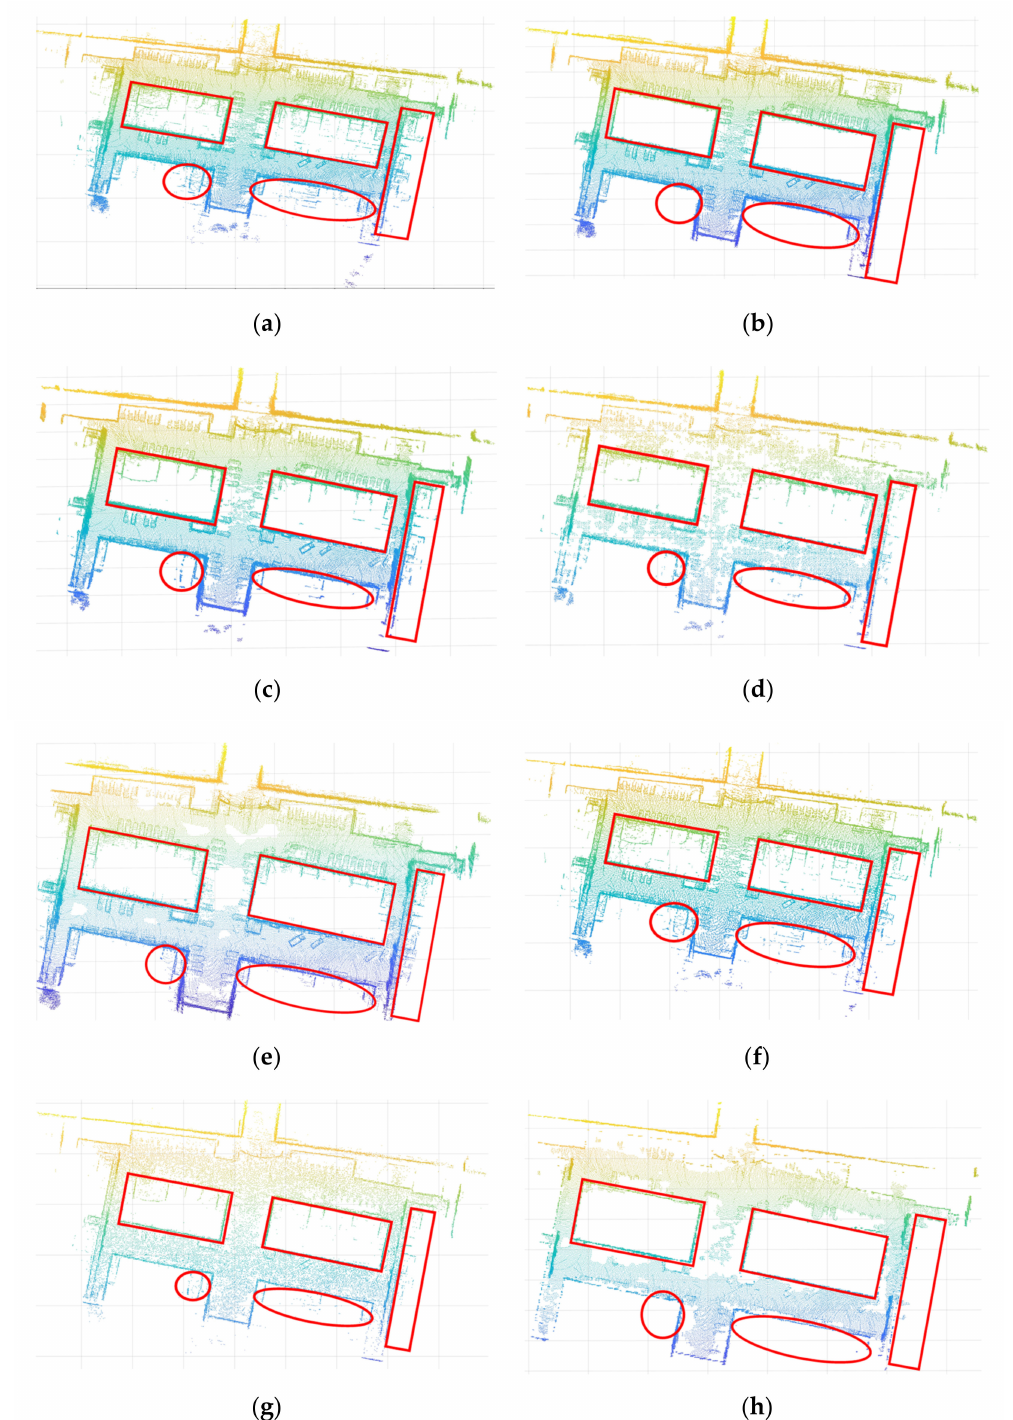
Figure 9. The results of several filtering processes, where the main noise is marked within the red shape: ( a ) the initial data collected; ( b ) the data processed by artificial filtering on the initial data; ( c ) the data processed by the statistical outlier removal (SOR) filter; ( d ) the data processed by the SOR filter on the basis of voxel grid filter processing (the voxel grid statistical outlier removal (VGSOR) filter); ( e ) the data processed by the radius outlier removal (ROR) filter; ( f ) the data processed by the Gaussian filter; ( g ) the data processed by the difference of normals (DON) method; and ( h ) the data processed by the GPCA